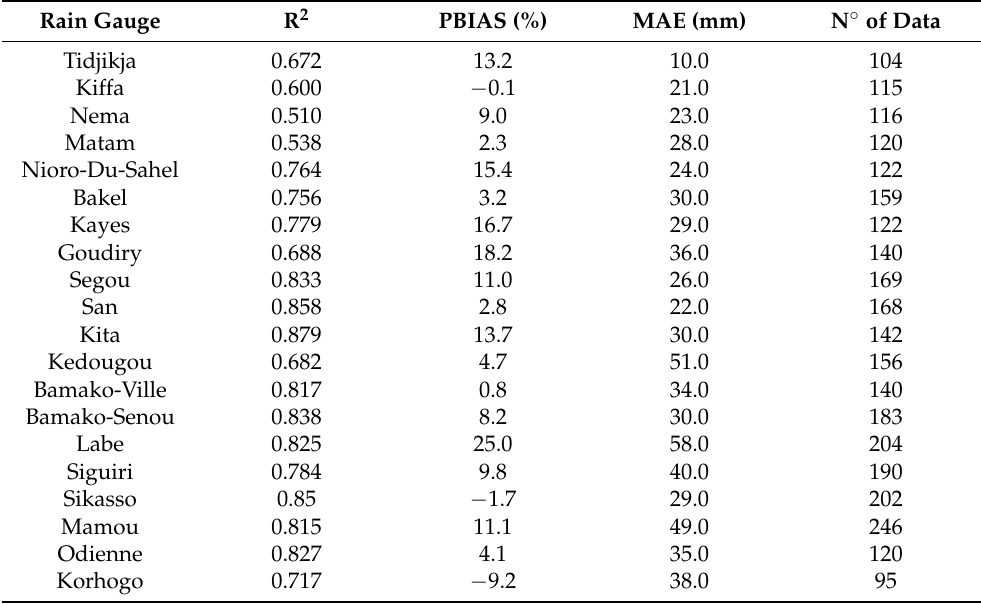
Table 1. Validation of monthly precipitation of the PERSIANN-CDR product with the observed data of 20 rain gauges between 1983 and 2014.